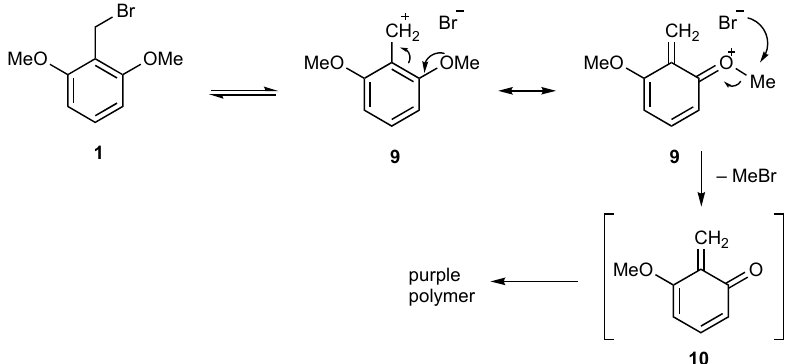
Scheme 2. Suggested mode of decomposition for 1